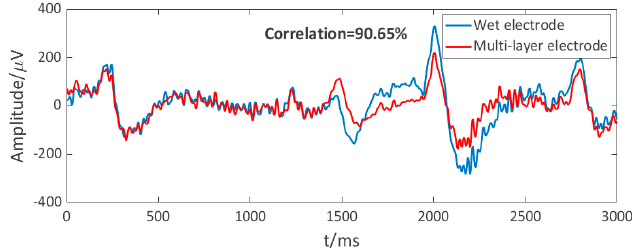
Figure 12. Dynamic EEG signals of the multi-layer electrode and wet electrode.